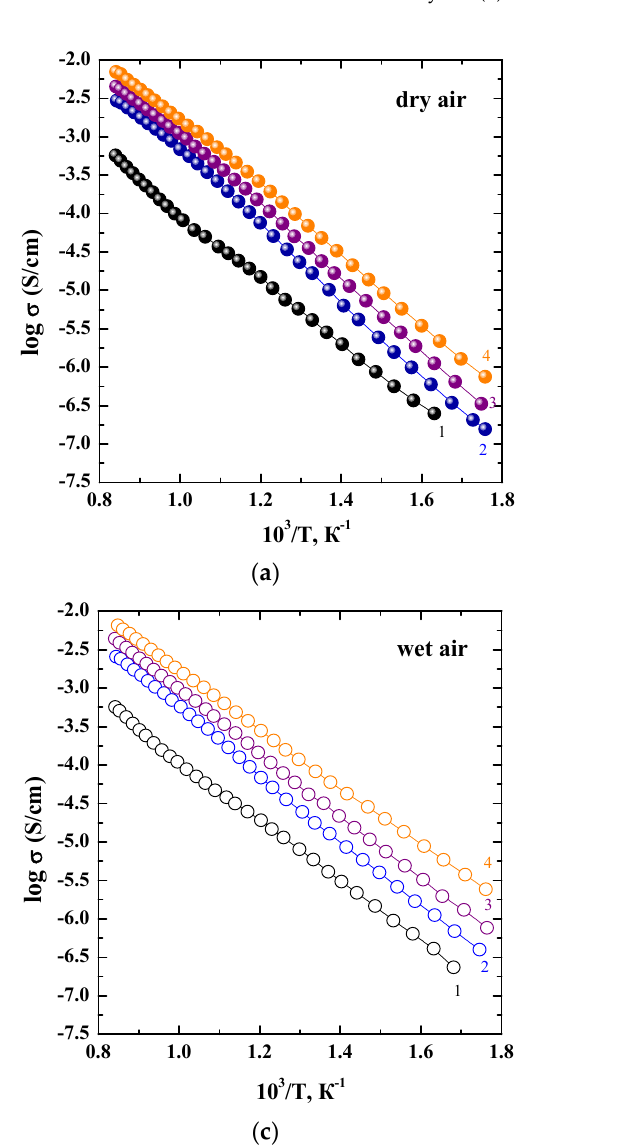
Figure 3. The EIS plots for the composition BaLa 1.75 Sr 0.15 Gd 0.1 In 2 O 6.925 obtained at 390 °C, 410 °C and 430 °C in dry air ( a ) and at 410 °C in dry and wet air ( b ).